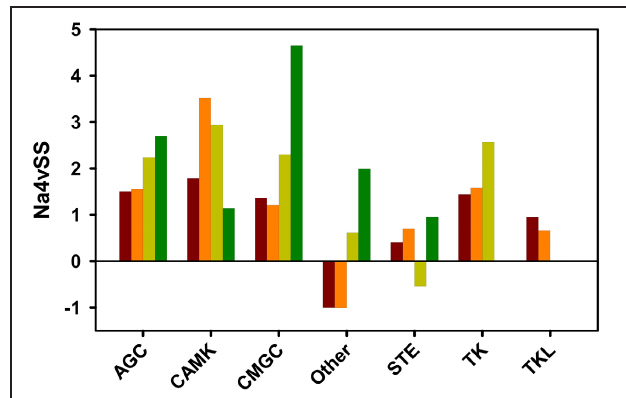
FIGURE 10 | Average aggregation propensity (Na4vSS) for discrete domain datasets of kinase groups in different organisms: human (brown), mouse (orange), fruit fly (light green), and budding yeast (dark green). Only the groups considered previously in the human kinome analysis are